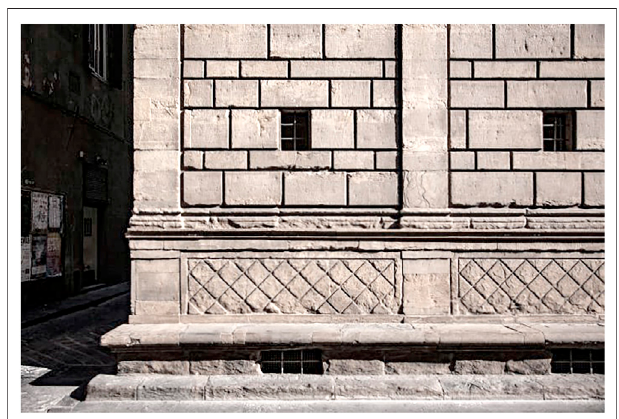
FIGURE 3 | The exterior of a building envelope can ful fi ll various functions, as shown by the integrated bench providing a resting place for passers-by at the Palazzo Rucellai designed by Leon Battista Alberti (15th century) (Alberti, n.d.).